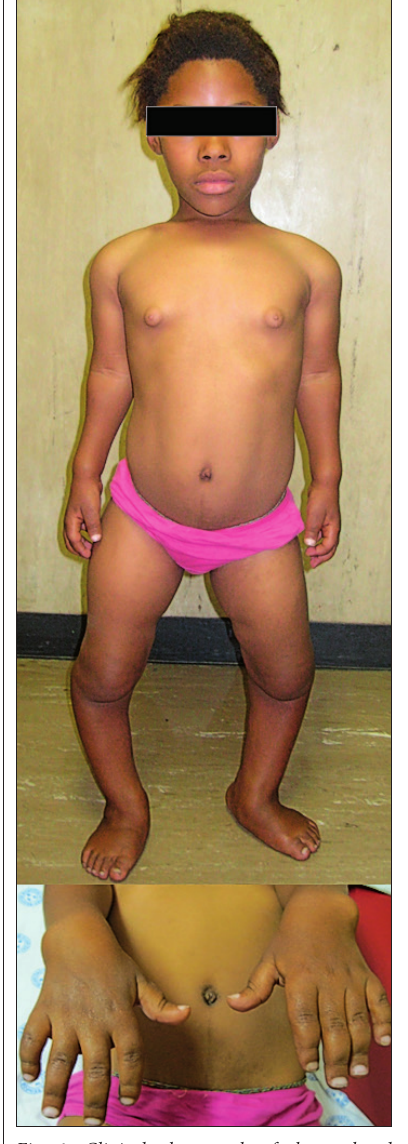
bones.Fig. 1. Clinical photograph of the proband